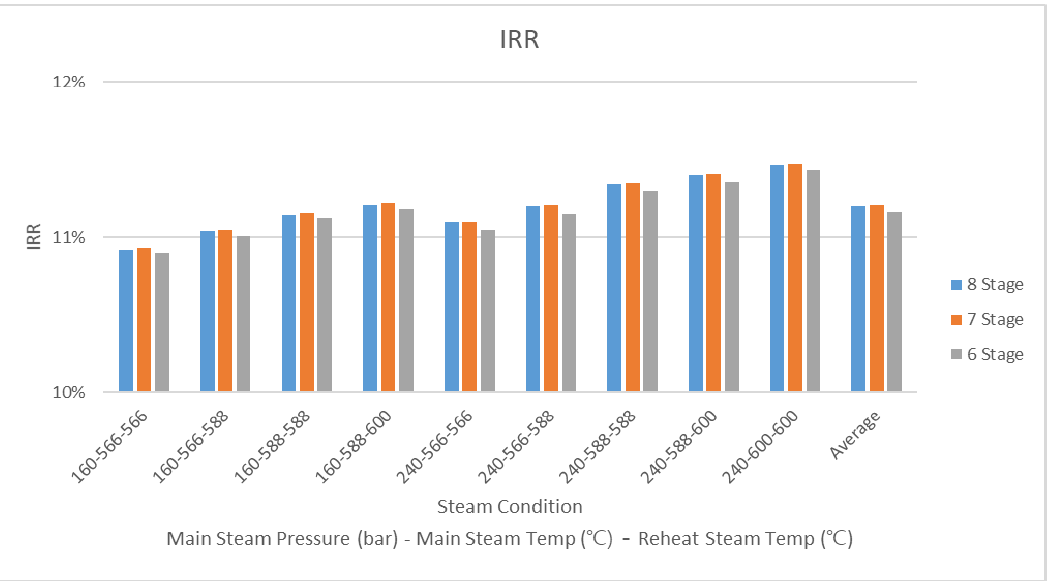
Figure 7. IRR average according to steam condition and heater stage.